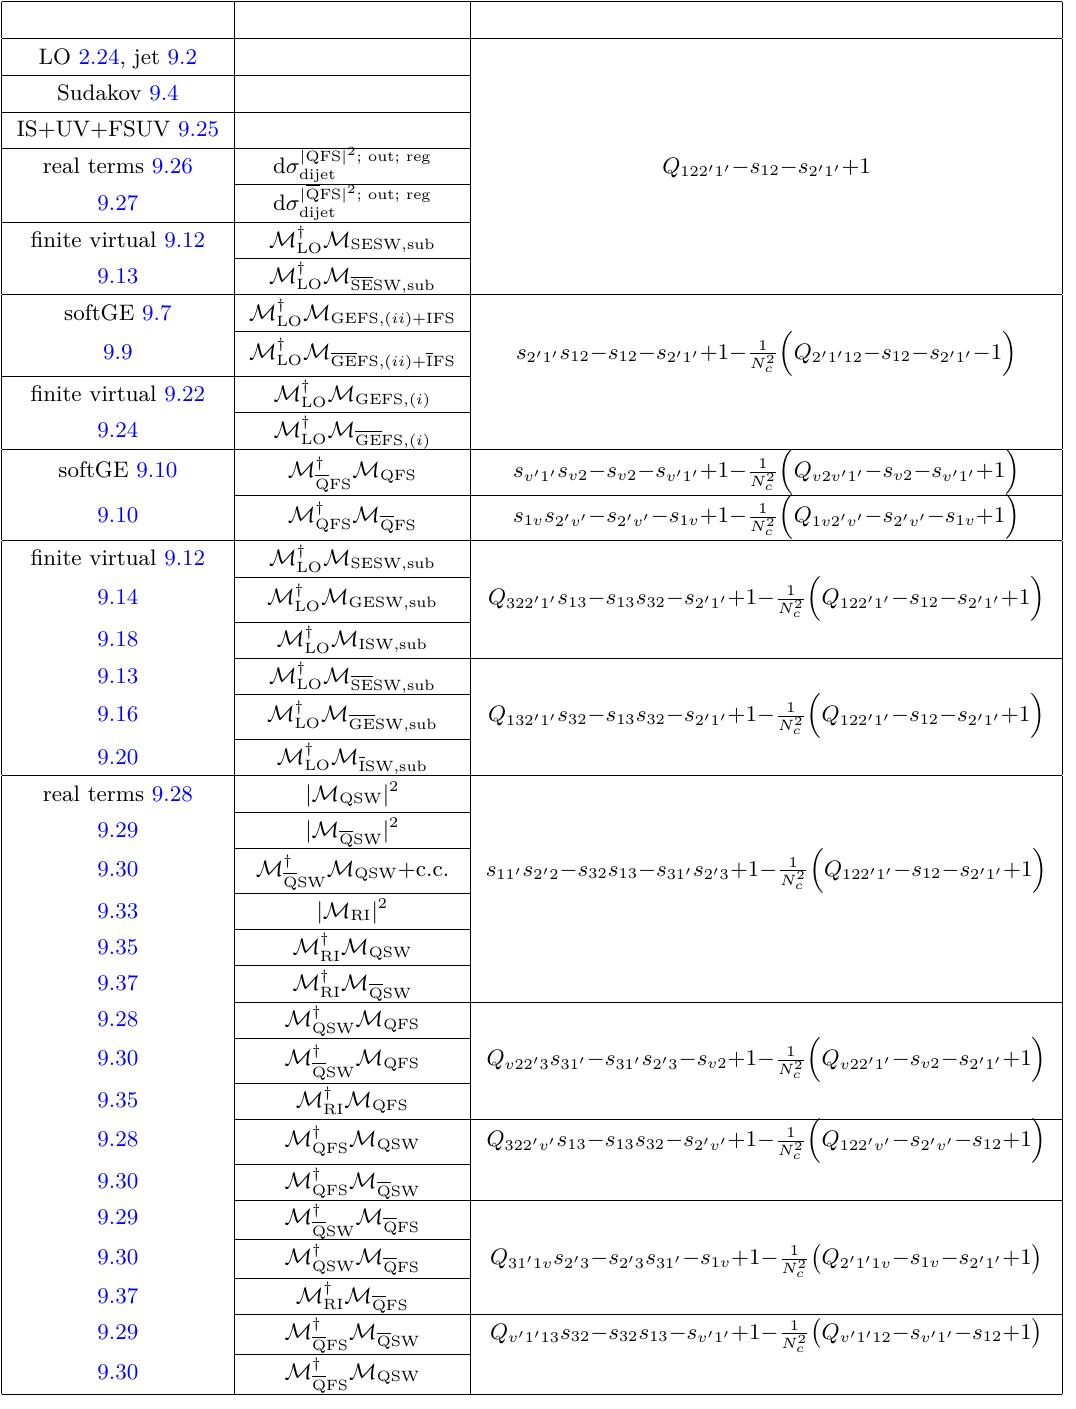
Table 3 . The different Wilson-line structures appearing in the NLO cross